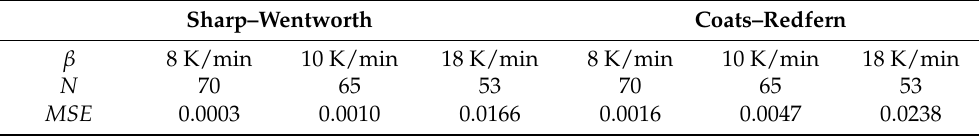
Table 8. The mean square errors of the reaction of Fe 3 O 4 → Fe for Taylor